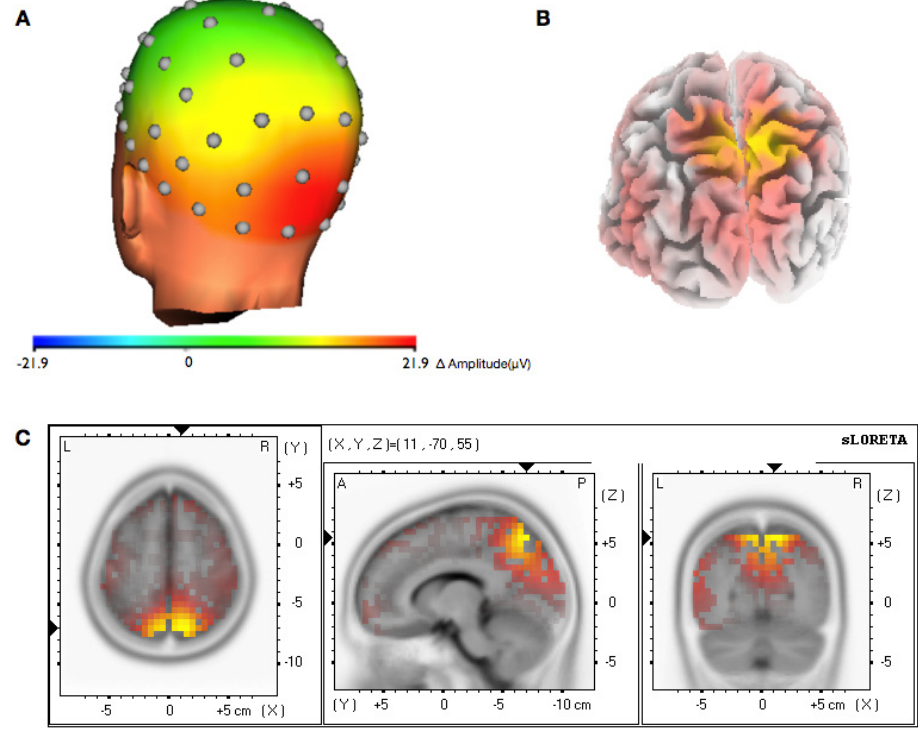
Figure 6. Topographic and spatial distribution of alpha band increase. ( A ) Topographic representation of the average change of the alpha-band activity (8–12Hz) during the feedback period compared to the passive period within the last training session. The maximum change is localized at the occipital and parietal lobes; ( B ) sLORETA analysis of the subtracted electrode potential difference of the alpha feedback sessions compared to the passive baseline. The yellow area represents the maximum estimated change of the alpha band activity to baseline. ( Back view ); ( C ) Horizontal, sagital and coronal view of the maximum change of the alpha-band